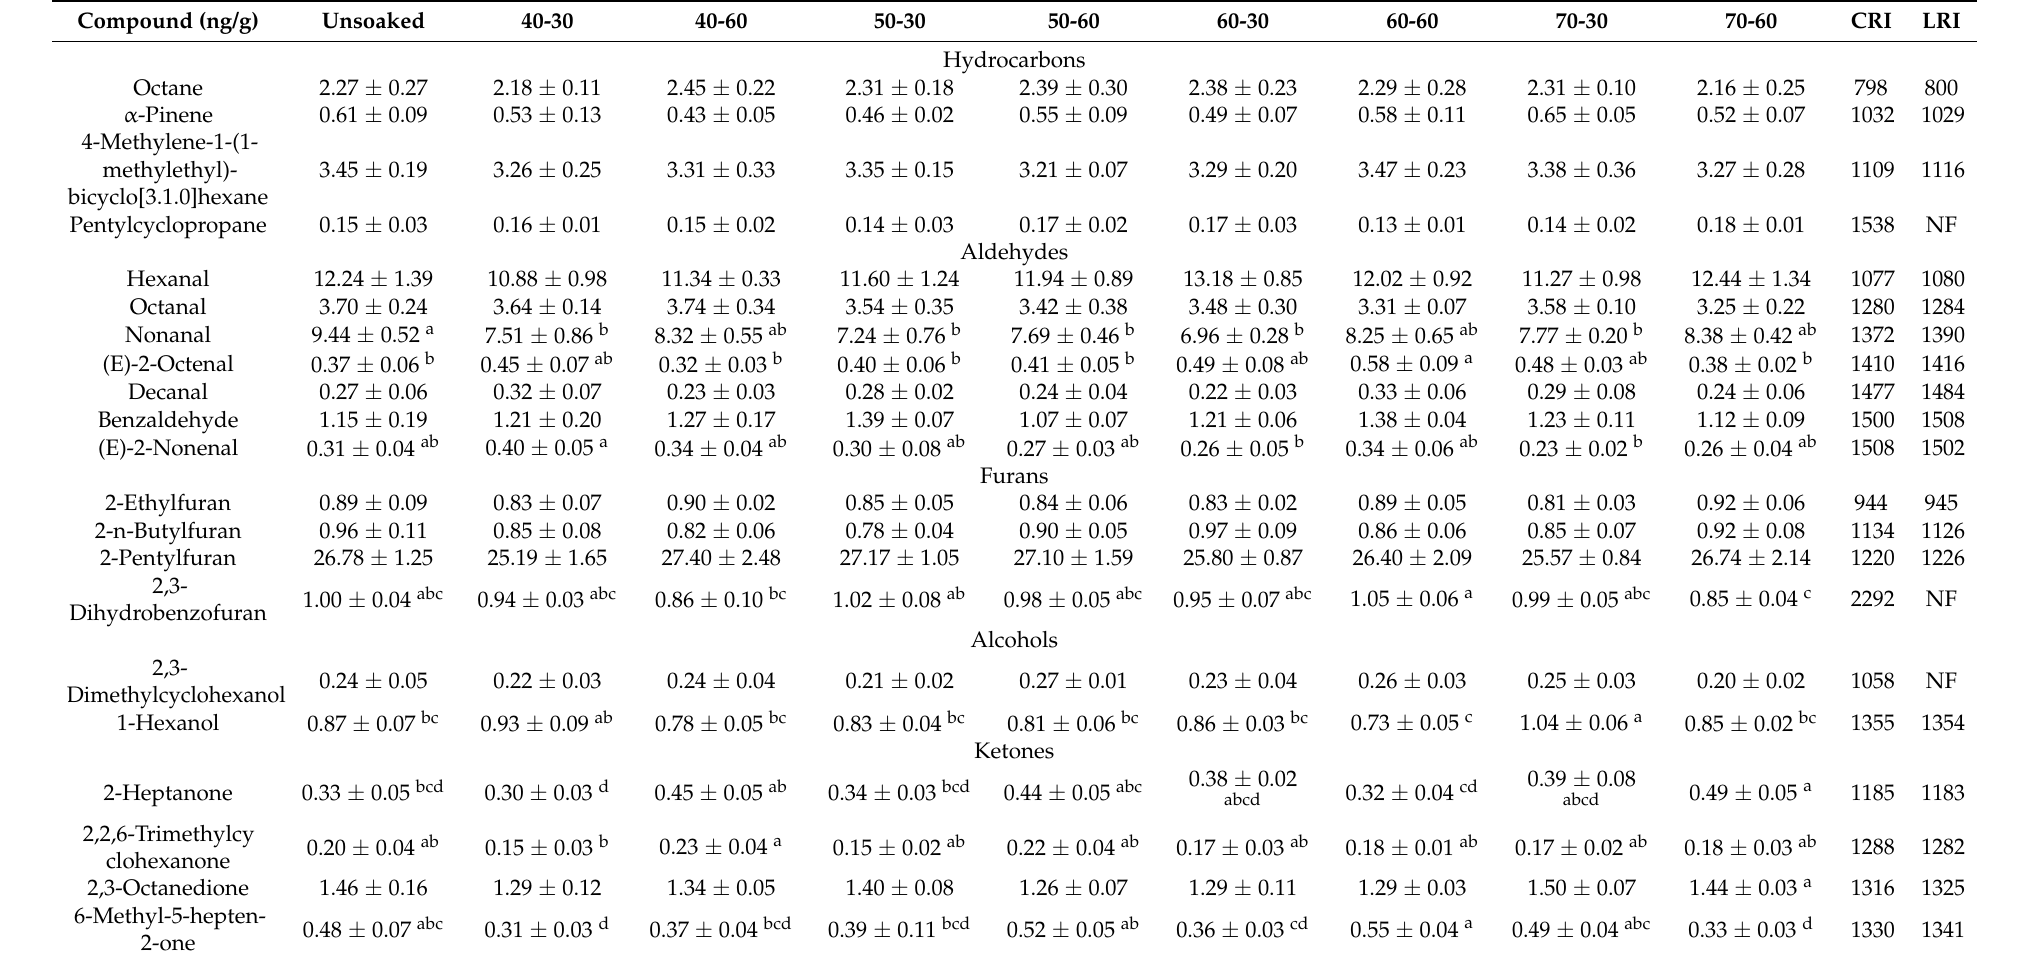
Table 1. Volatiles profile of cooked brown rice under different soaking conditions during